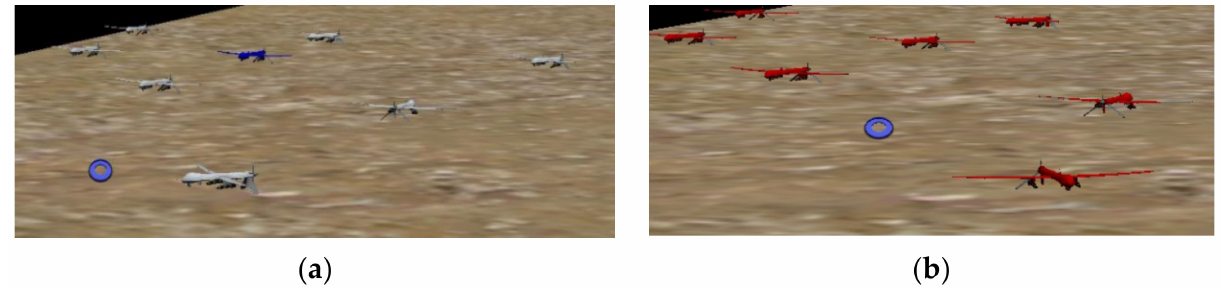
Figure 5. Battlefield awareness of drone formations (( a ) UAVs on search mission; ( b ) UAVs change formation and color after spotting a target).